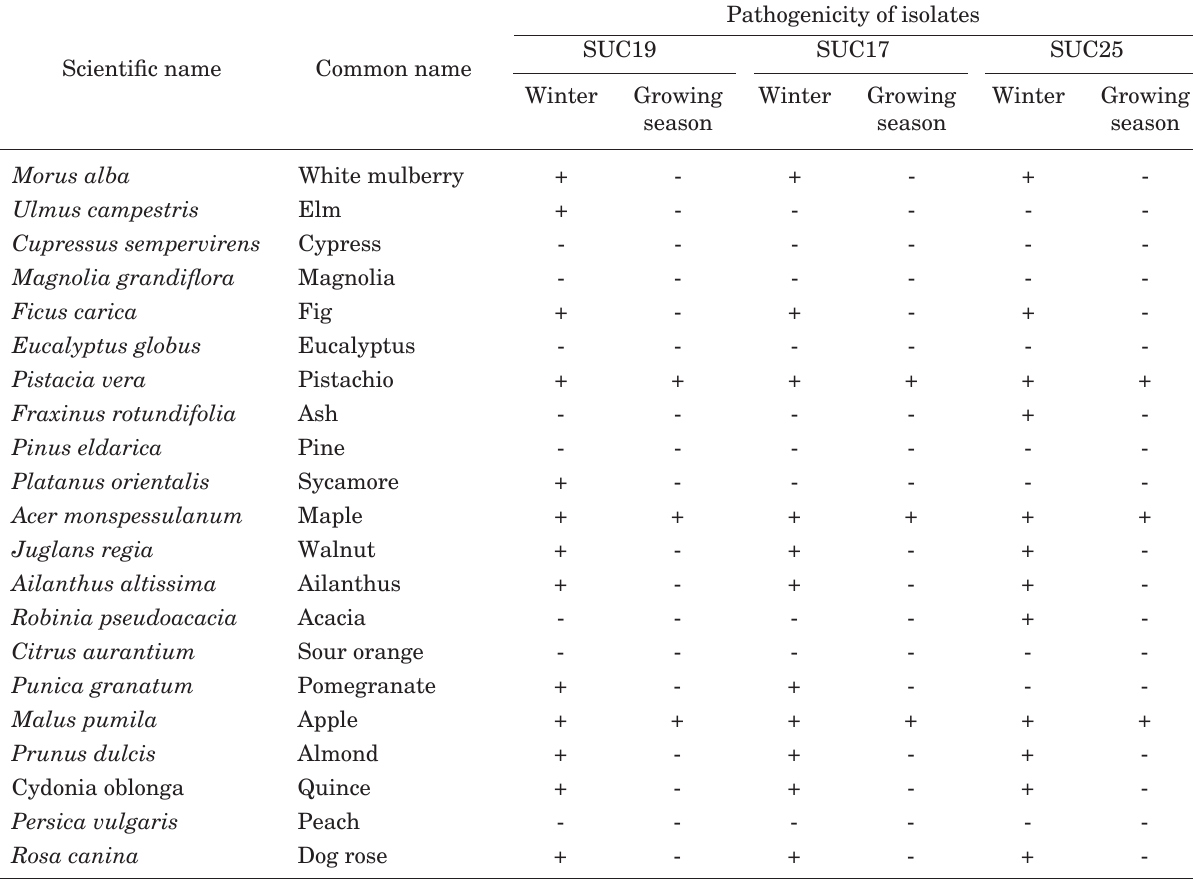
Table 4. Pathogenicity of isolates of Phytophthora parsiana on detached stems of different woody